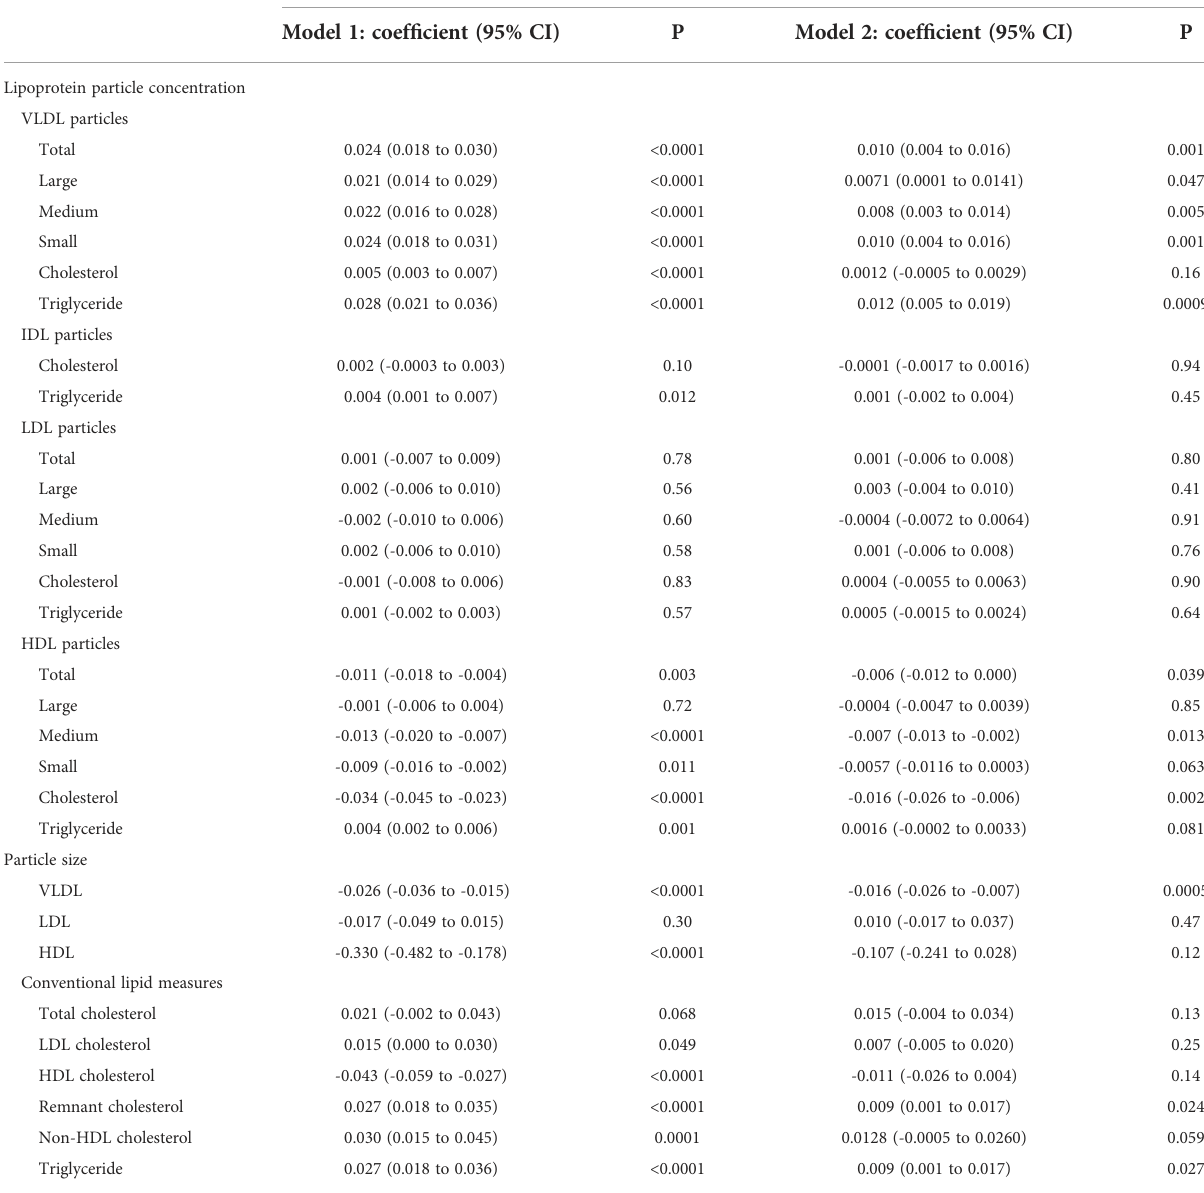
TABLE 3 Linear association of WHR with lipid